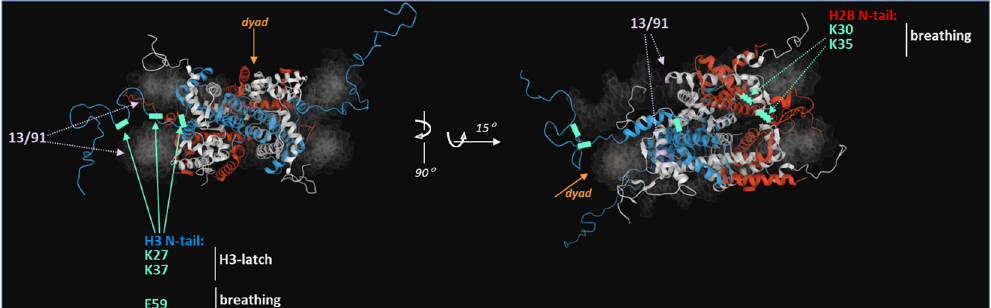
Figure 4. NCP contacts—involved in the stabilisation of NCP structure through the H3-latch and breathing—that could be potentially affected by PARP1 interaction and subsequent PARylation (data from [23,163,167]). Specific PARylation sites in these regions are highlighted in a mint colour and indicated by mint arrows (a dashed line for H2B contacts and a solid line for H3 contacts). DNA is blurred, and histones H2A and H4 are highlighted in white for clarity. The dyad is highlighted in orange. Dashed whitishe-pink arrows go to positions of the fluorescent dyes that were used for the investigation into the molecular dynamics of the NCP after PARP1 binding and PARylation [163,167].